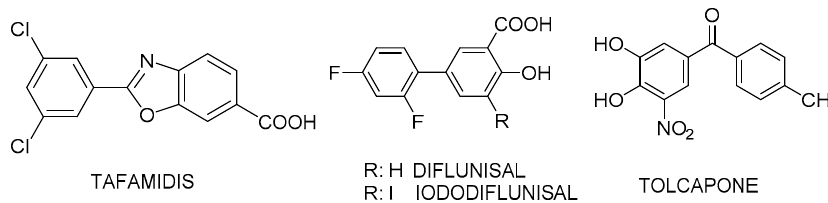
Scheme 1. Chemical structures of TTR tetramer stabilizers: the orphan drug tafamidis, the Non- steroidal anti-inflammatory drug (NSAID) diflunisal, the repurposed drug tolcapone for Familial amyloid polyneuropathy (FAP) and our lead compound iododiflunisal (IDIF).